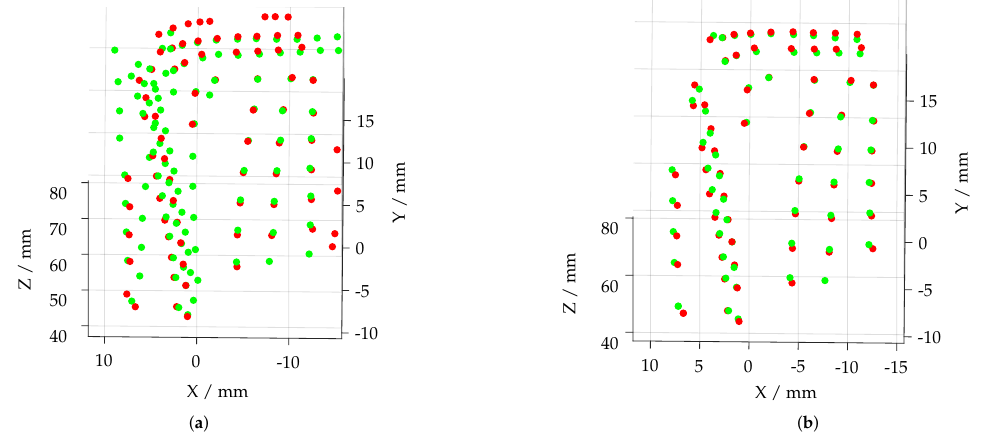
Figure 10. Registration of segmented film-cooling holes of measurement data (red) and reference model (green). ( a ) Features matched after (19). ( b ) Features matched after (22).